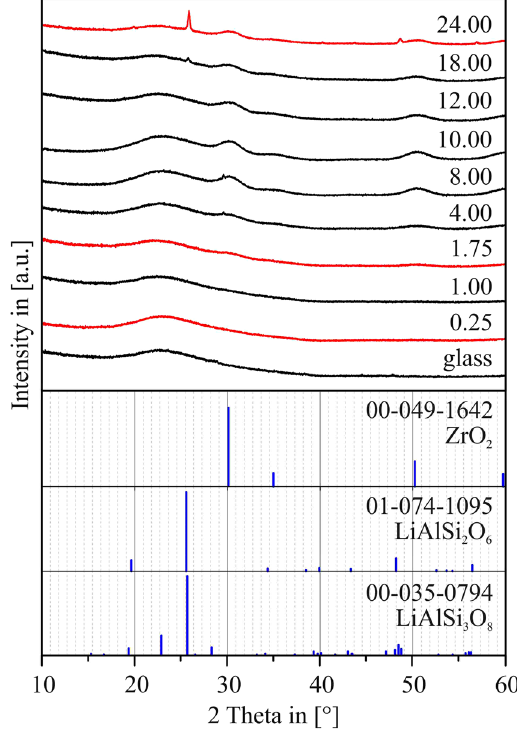
Figure 1. XRD patterns of LAS glass samples thermally treated at 725 °C for different periods of time [h]. The red highlighted patterns are described in detail in the discussion.